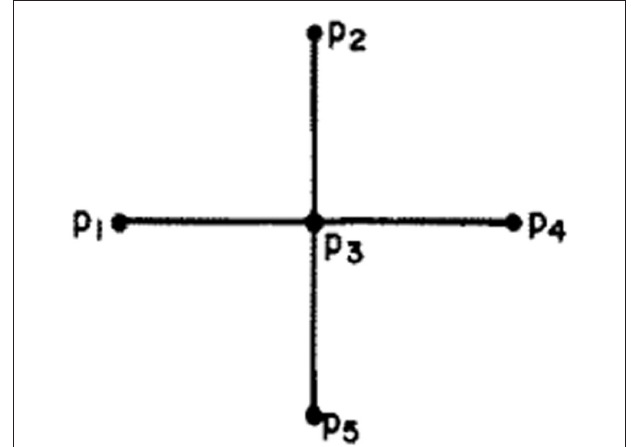
FIGURE 5 | A simple graph with five